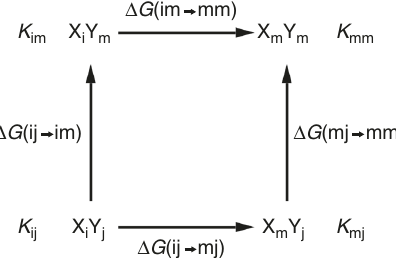
Fig. 1 Double-mutant cycle for measuring inter-protein pairwise interactions. X and Y stand for two proteins and i and j for two residues in these respective proteins that are mutated to some other residue (e.g., alanine) designated by ‘ m ’ . The binding constants corresponding to the formation of the four complexes in the cycle and the free energies changes upon the mutations are also indicated in the